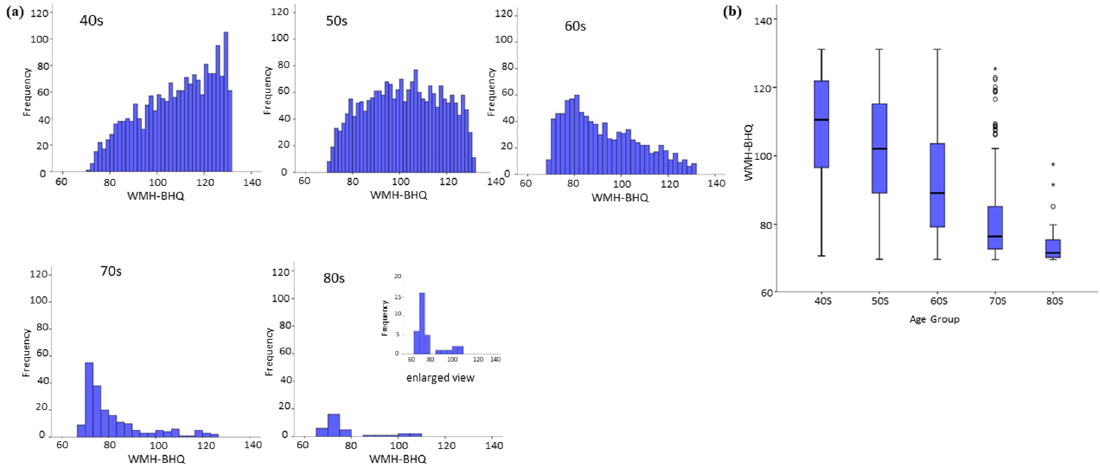
Figure 1. Histograms ( a ) and box plots ( b ) of WMH-BHQ with no medical history according to age decades of 40s, 50s, 60s, 70s, and 80s.